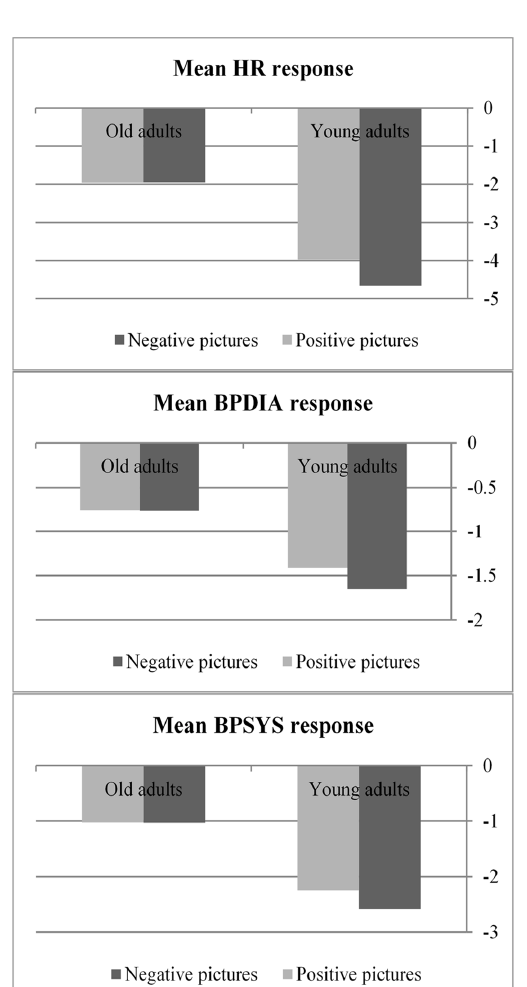
Figure A1. Mean heart rate (HR), mean diastolic blood pressure (BPDIA), and mean systolic blood pressure (BPSYS) during negative and positive picture presentations as compared to the baseline, for older adults (N = 20) and young adults (N =